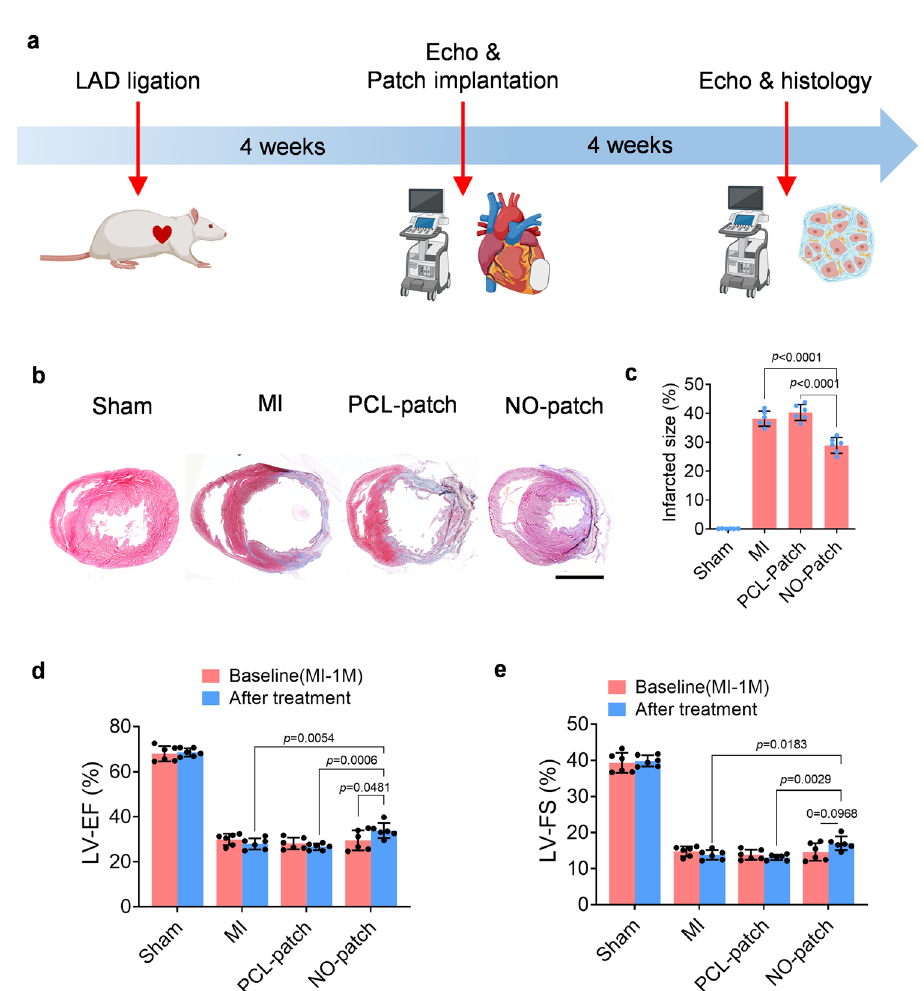
Fig. 7 Local NO delivery exerts cardioprotective roles in a chronic rat MI model. a Schematic image showing the NO-patch treatment for a chronic rat MI model. b Representative Masson trichrome staining images of the heart 4 weeks after different treatments. Scale bar, 5 mm. c The infarct size was calculated according to Masson staining. d – e . Quantitative data of echocardiography for measurement of cardiac function, and representatively, the left ventricular (LV) ejection fraction (LV-EF) and fraction shortening (LV-FS) were shown. Data are expressed as mean ± SEM, n = 6 animals for each group. Signi fi cant differences were detected by two-tailed one-way ( b ) or two-way ( d and e ) ANOVA with Tukey ’ s multiple comparisons test. LAD: left anterior descending